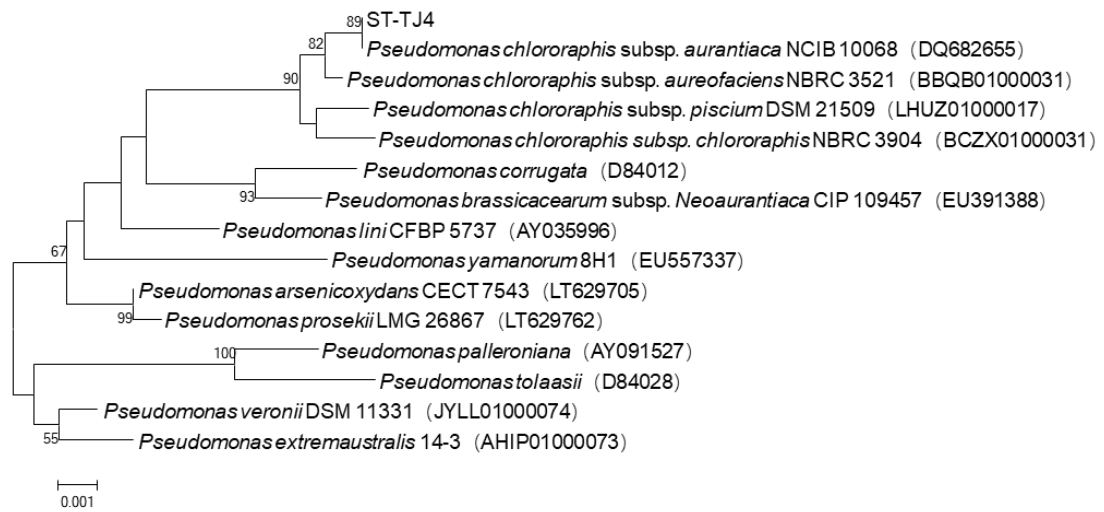
Figure 7. Phylogenetic tree derived from the 16S rRNA-encoding gene sequences of strain ST–TJ4 and related taxa of Pseudomonas . The tree was constructed using the neighbor-joining method using MEGA 7.0. The bootstrap test was conducted with 1000 replicates. Bootstrap values >50% were indicated at the nodes. The scale bar represents substitutions per nucleotide position.